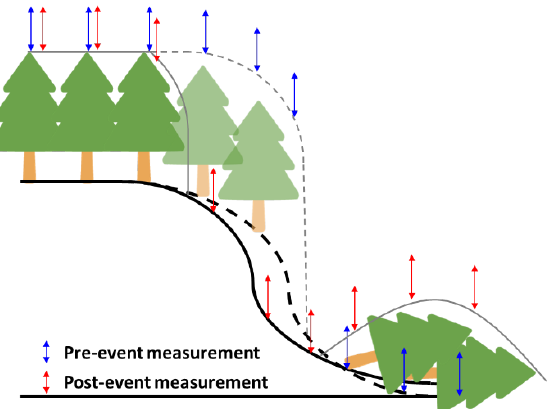
Figure 11. Concept image for the reason the decreased volume of the DSM would be much larger than the increased volume after a landslide. Table 2. Comparison of the detected results with the landslides identified by GSI.